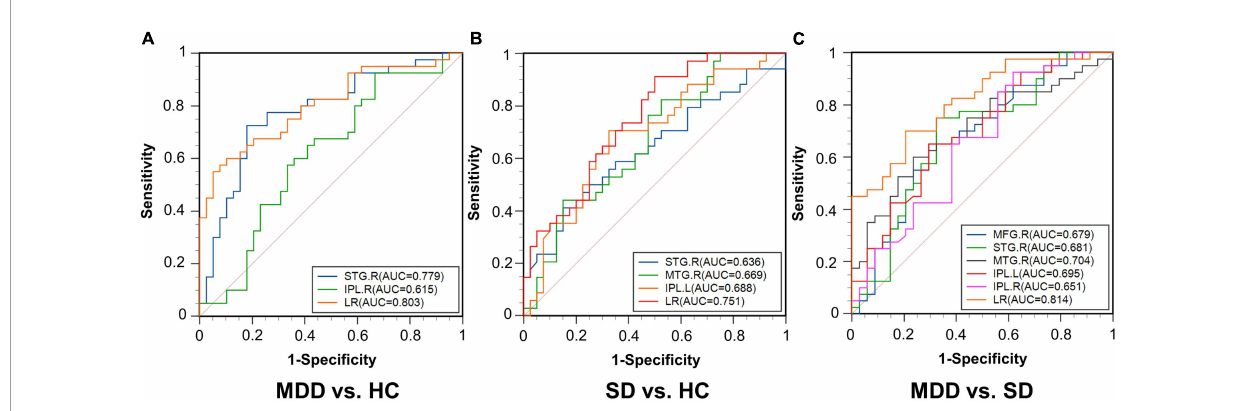
FIGURE5 Receiver operating characteristic curves for the three comparisons. (A) MDD vs. HC; (B) SD vs. HC; (C) MDD vs. SD. AUC, area under the curve; STG.R, right superior temporal gyrus; IPL.R, right inferior parietal lobule; LR, logistic regression; MTG.R, right middle temporal gyrus; IPL.L, left inferior parietal lobule; MFG.R, right middle frontal